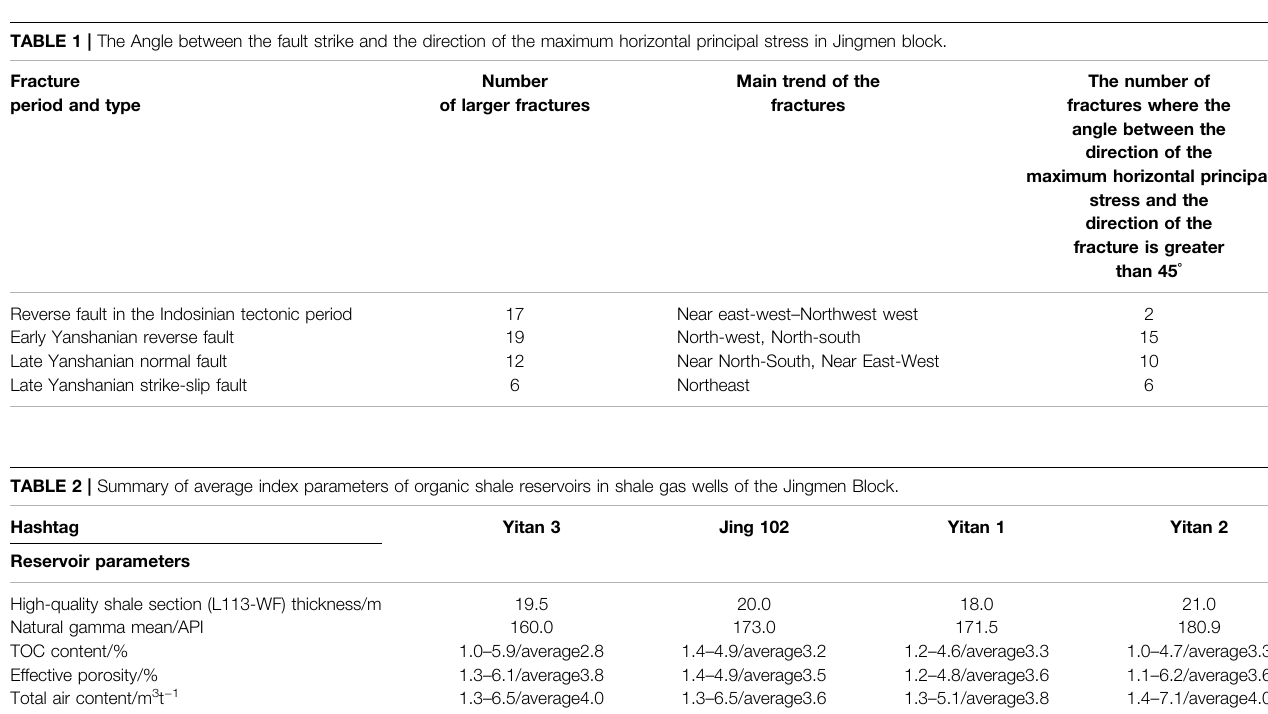
Number of larger fractures